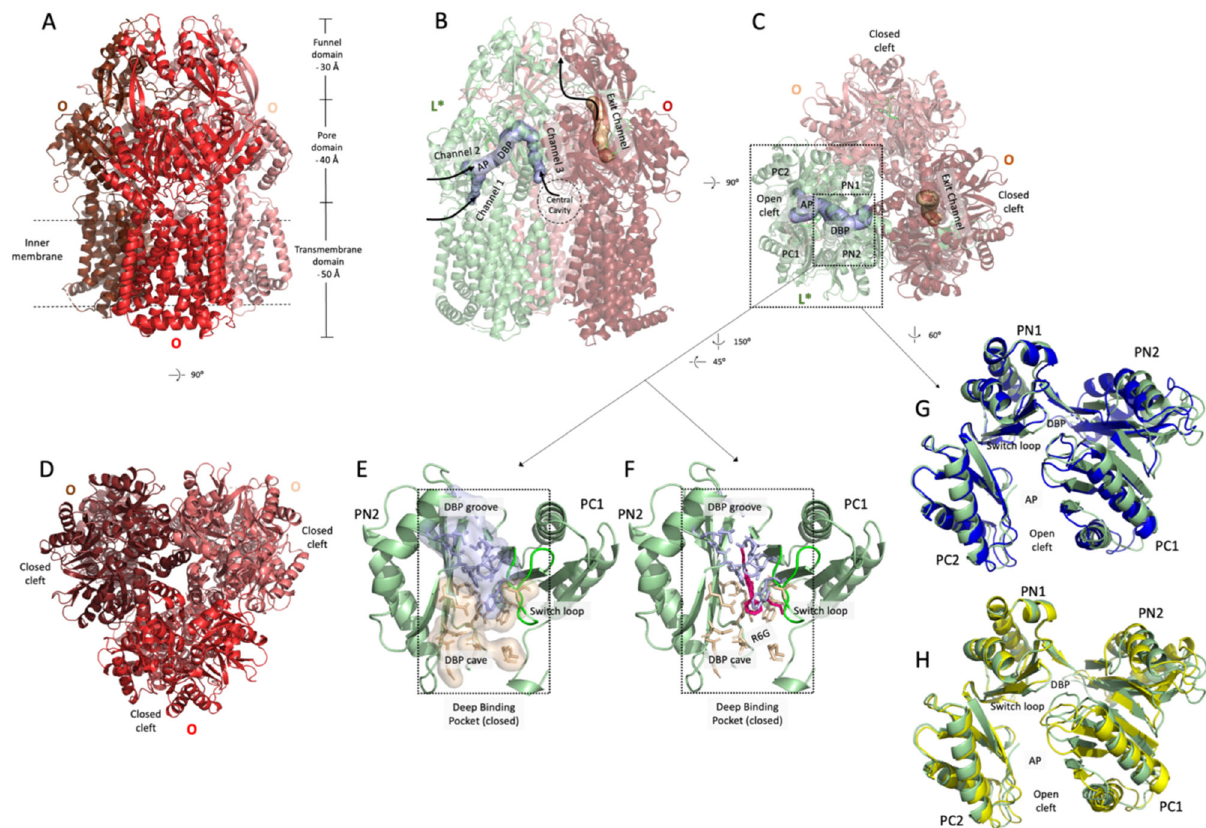
Fig. 2 Structural models of AdeB in the OOO and L*OO conformations. A Side view of the C3-symmetric structure of AdeB in the OOO conformation solved at 3.54 Å. The approximate boundary of the inner membrane embedded part of AdeB is indicated by dashed lines. The dimensions of the transmembrane, porter and funnel domains are indicated. B From the same sample, we obtained a structure of AdeB in the L*OO conformation at 3.84 Å resolution shown in side view. C Top view of AdeB in the L*OO conformation. The L* conformation (Chain A of the PDB entry: 7B8Q) is depicted in green, and the O conformation in light and dark red. Tunnels were calculated with CAVER Analyst 34 . Channels 1, 2 and 3, leading to the closed DBP, are marked in the L* conformation. The PC1 and PC2 subdomains constitute an open cleft in L* conformation (channel 2 entrance). All entry sites are closed in the O conformation, and an exit channel is opened. In the O conformation, the PC1 and PC2 subdomains are in close contact constituting a closed cleft. D Top view of the C3-symmetric structure of AdeB in the OOO conformation. E The DBP cave (wheat surface and side chains in sticks) and groove (light blue) regions are closed in the L* conformation F Rhodamine 6G (R6G) derived from the co-structure of AcrBper (PDB: 5ENS), superimposed on the AdeB L* conformation (green cartoon). Binding of R6G (pink sticks) to the DBP in this conformation is not possible. G A superposition on the PN1 subdomain of the L* conformation (green cartoon) with the AcrB L (blue cartoon) and H the AcrB T conformation (yellow cartoon) (PDB: 4DX5) shows clear deviations in the PN2 and PC1 subdomains. Latter subdomains in L* are arranged in a different state compared to the L and T conformations, while the PN1 and PC2 subdomains are congruent. The switch loop (L*, green) is shifted to the inside of the DBP compared to the switch loop in the AcrB T conformation (yellow, H ), congruent to the switch loop conformation in the L conformation of AcrB (blue, G ). AP, access pocket; DBP, deep-binding